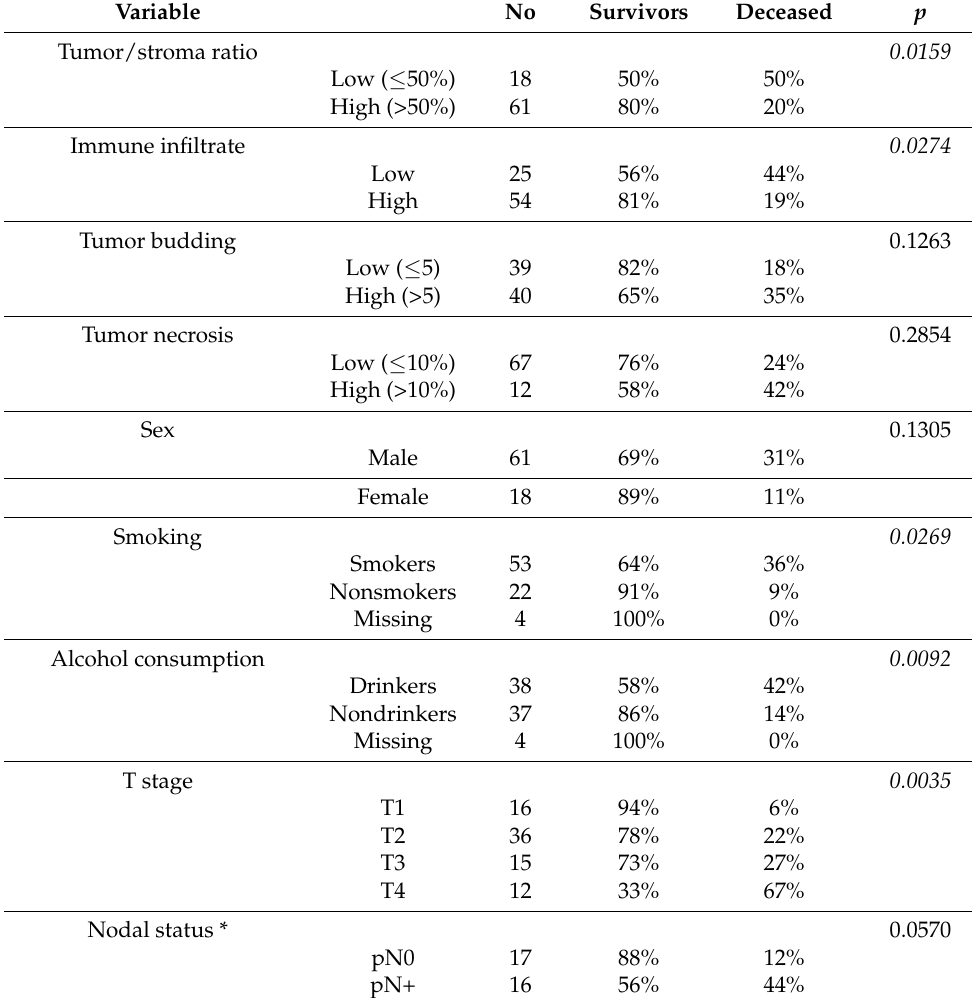
Table 4. Correlation analysis between histological features, clinicopathological characteristics, and outcome in OSCC. Variable No Survivors Deceased